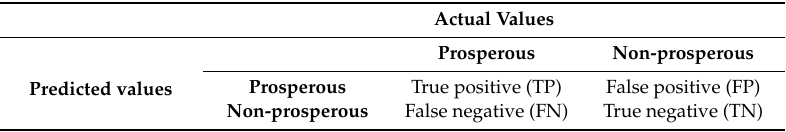
Table 3. Confusion